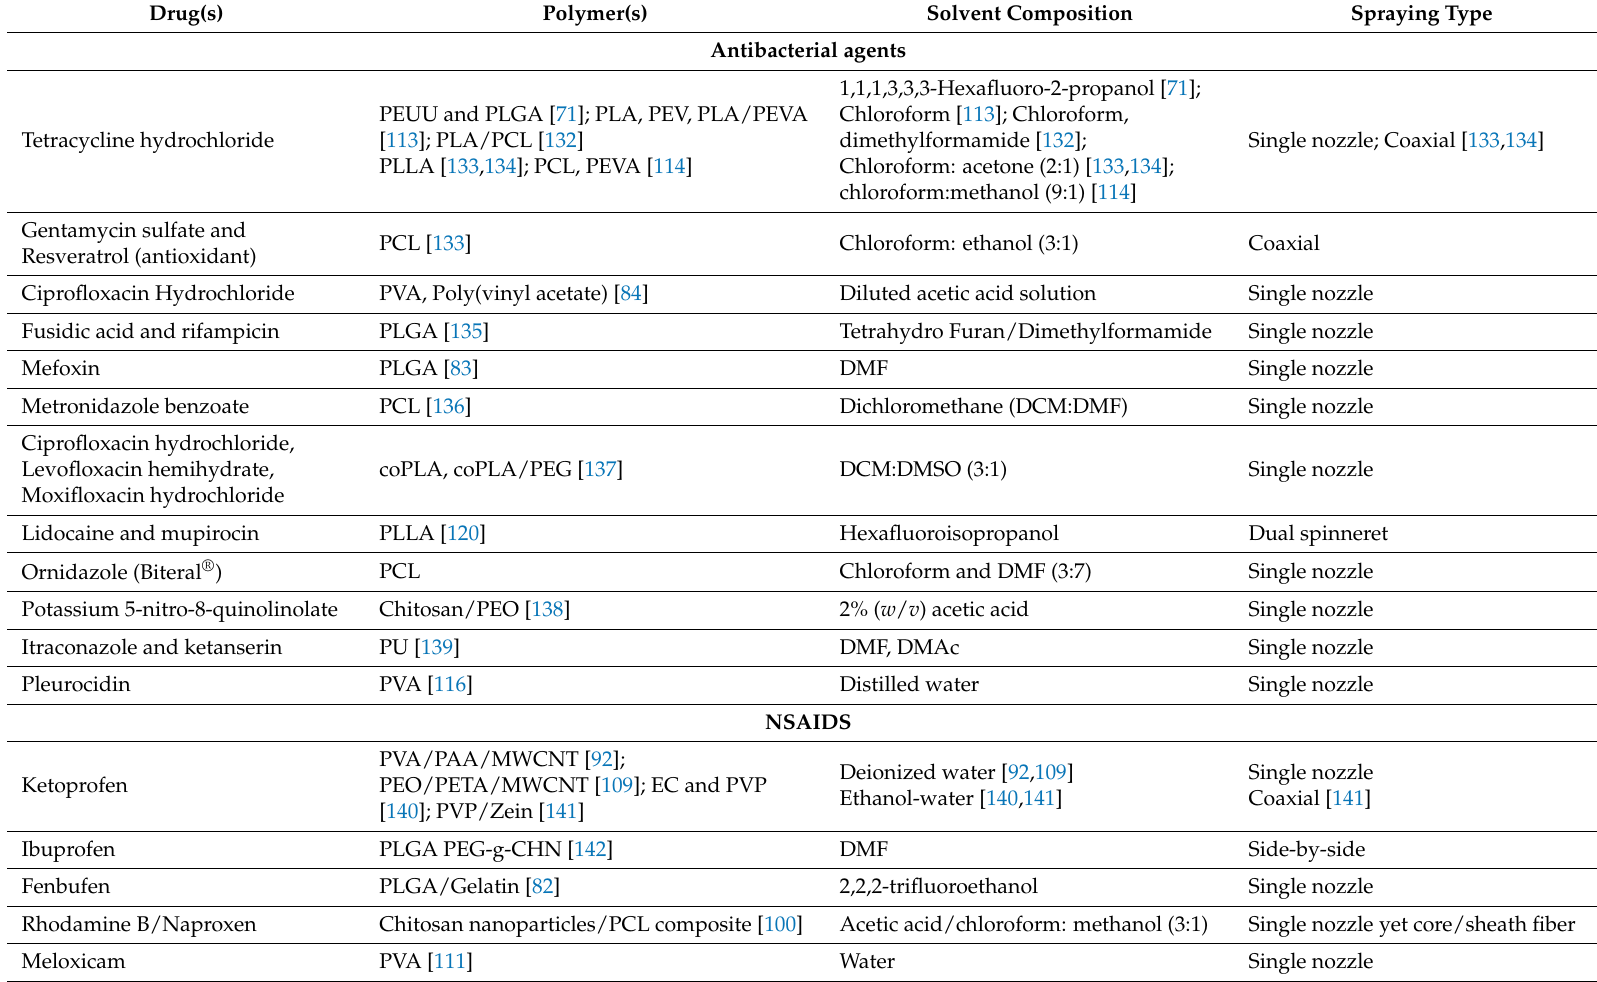
Table 1. Studies involving the use of electrospun fibers in drug delivery (partial